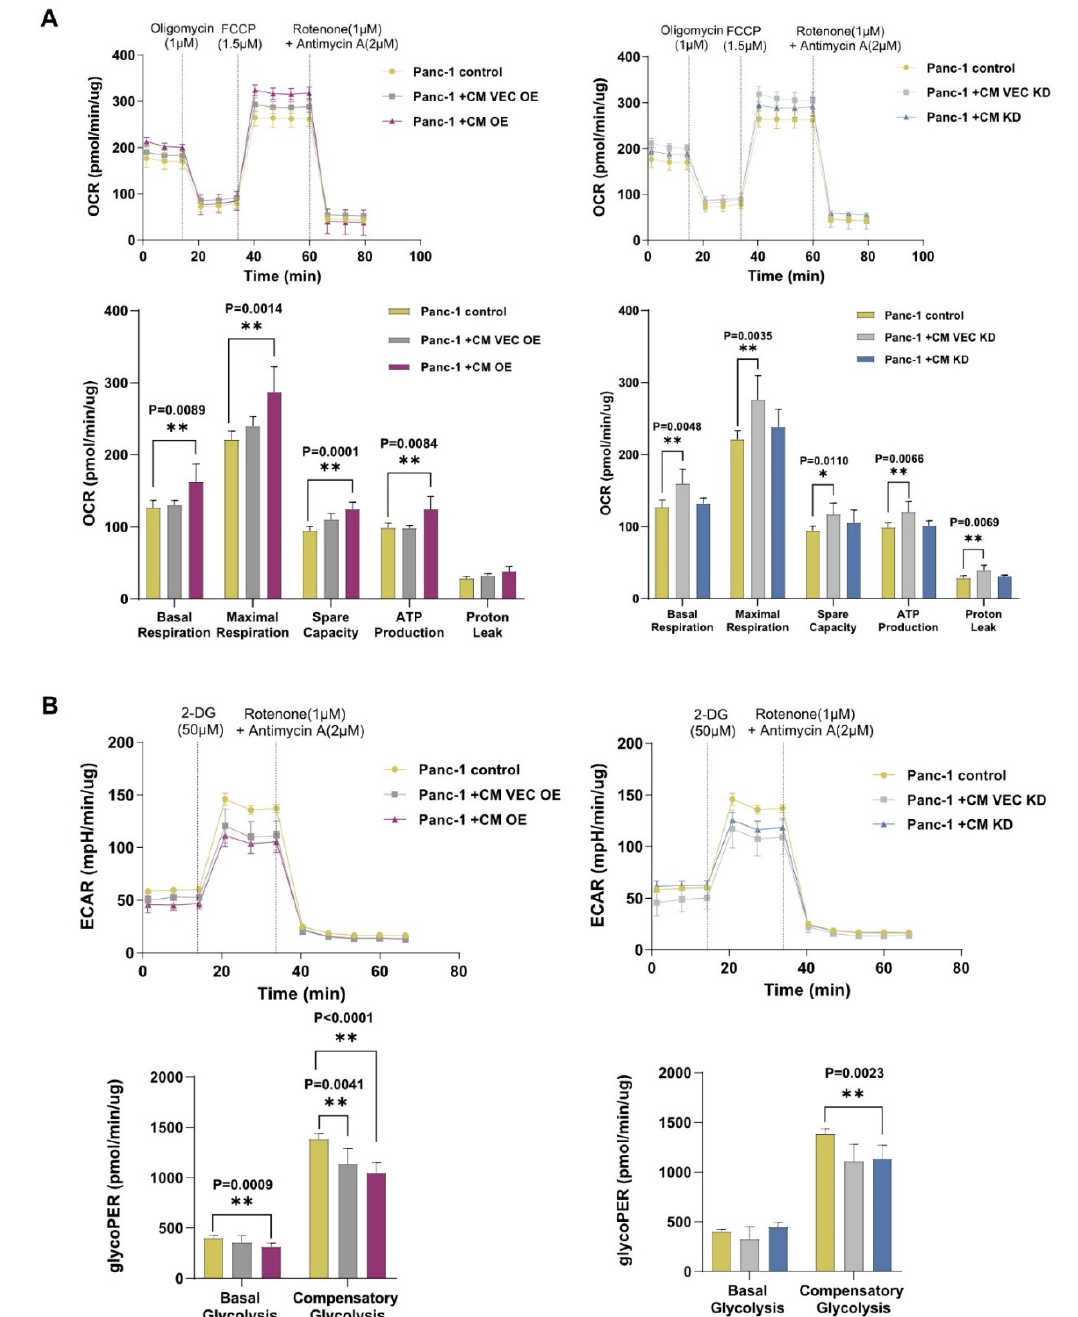
Figure 5. IL-17RB overexpressing PSCs increase mitochondrial respiration and decrease glycolysis ( A ) Conditioned medium from IL-17RB OE PSCs (CM OE) but not from IL-17RB KD (CM KD) increases mitochondrial respiration in Panc-1 tumor cells. Oxygen consumption rate (OCR) was measured with the Seahorse mito stress test. Seahorse profiles (upper panel) and statistical analysis (unpaired t -test, lower panel). Data represent the mean ( ± SD) of three independent experiments conducted in sextuplicate; ( B ) Conditioned medium from IL-17RB OE PSCs (CM OE, n = 6) decreases glycolysis in Panc-1 tumor cells. The glycolytic proton efflux rate (glycoPER) correlates with lactate accumulation over time, showing glycolysis. Seahorse profiles (up) and statistical analysis (unpaired t -test, down). Data represent the mean ( ± SD) of three independent experiments conducted in quintuplicate. * p < 0.05, ** p < 0.01.